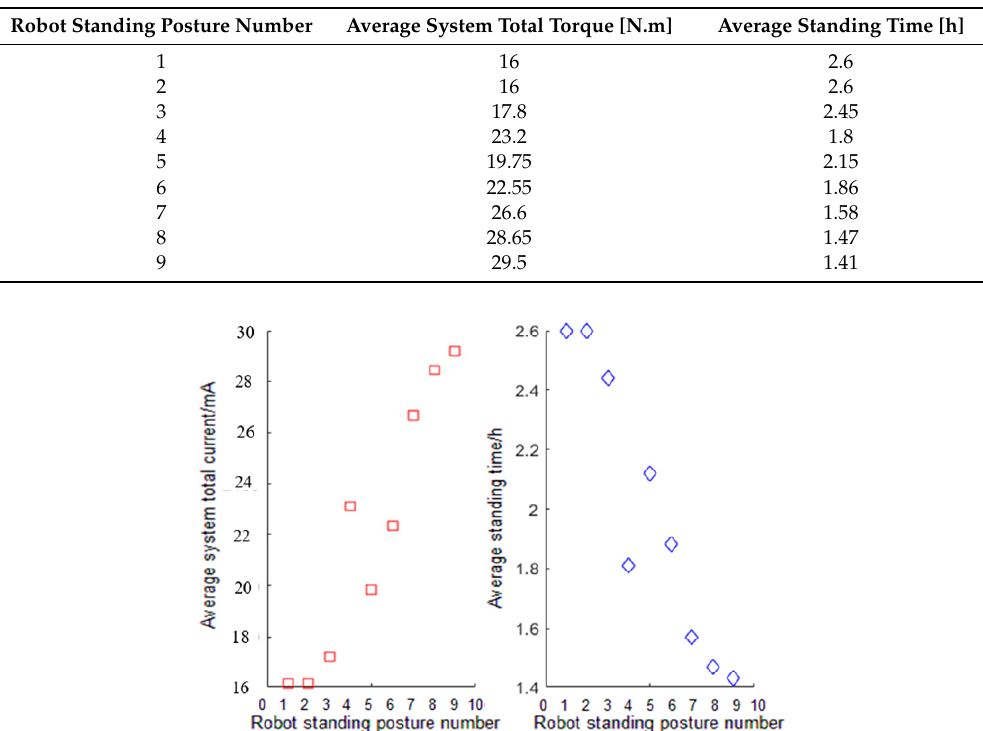
Figure 14. Energy consumption with different robot postures when only considering the energy consumption target.